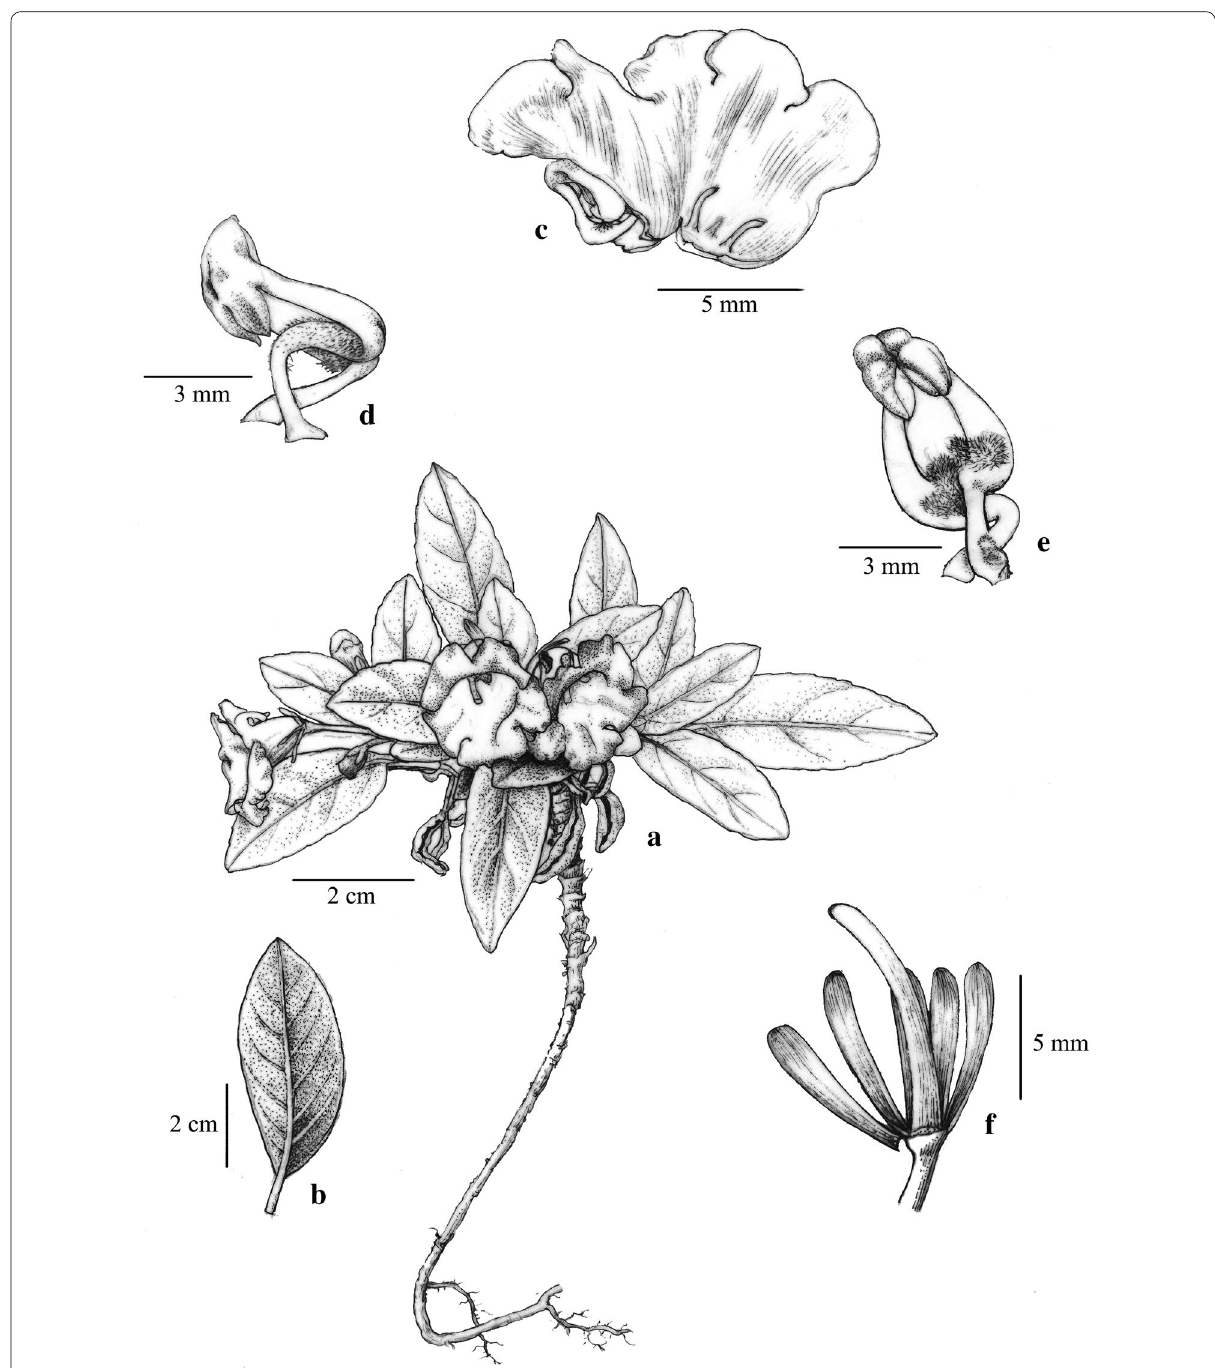
Fig. 4 Paraboea sinovietnamica W.B.Xu & J.Guo. a Habit; b lower surface of leaf; c opened corolla showing stamens and staminodes; d stamens side view; e stamens face view; f pistil and calyx (Drawn by W.H. Lin from the